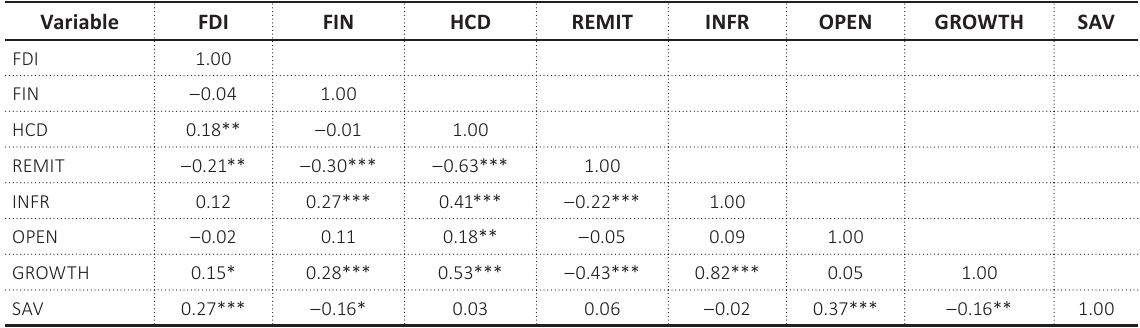
Table 2. Correlation analysis